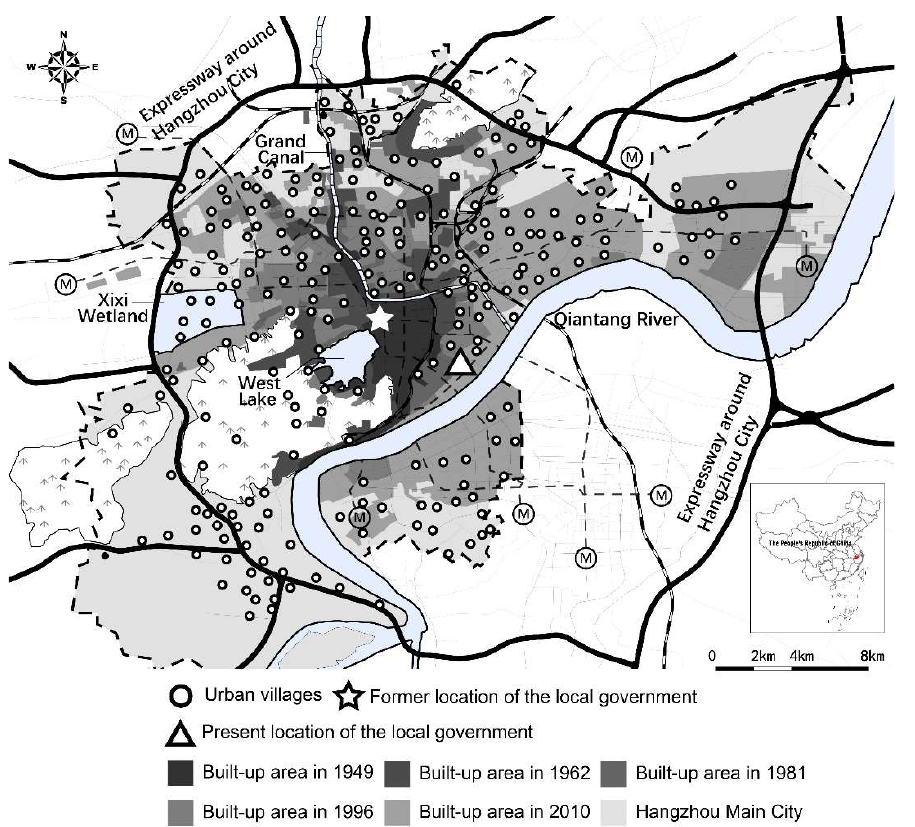
Figure 3. Distribution of urban villages in Hangzhou main city.